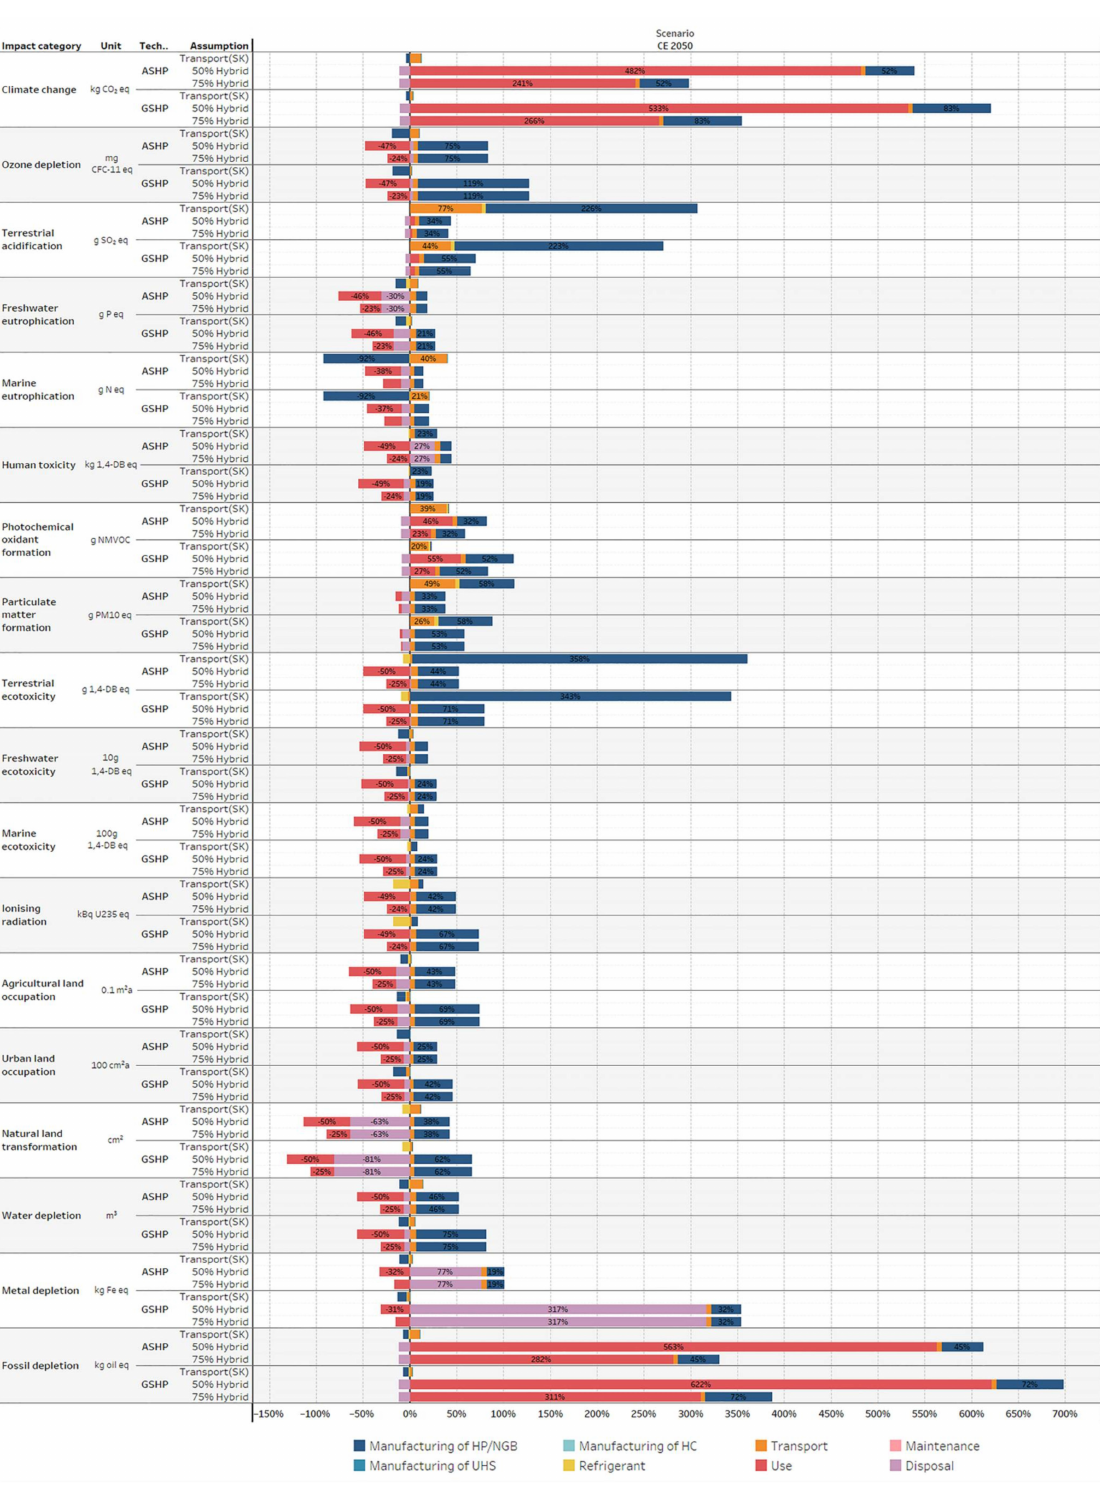
Figure 8. Lifecycle environmental impact change of phases for Transport (SK) and Hybrid scenarios according to CE